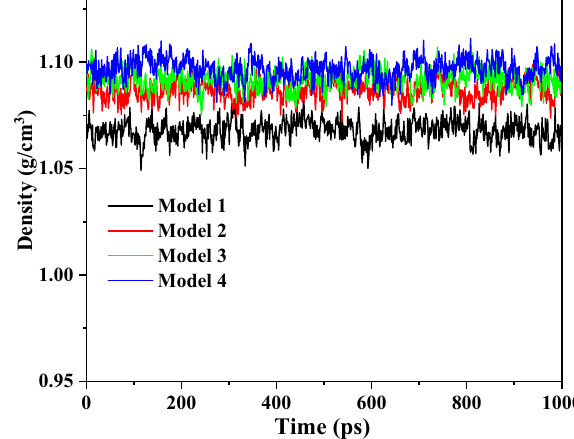
Fig. 17 Simulated density of the nano-silica/PDMS models as a function of simulation time.